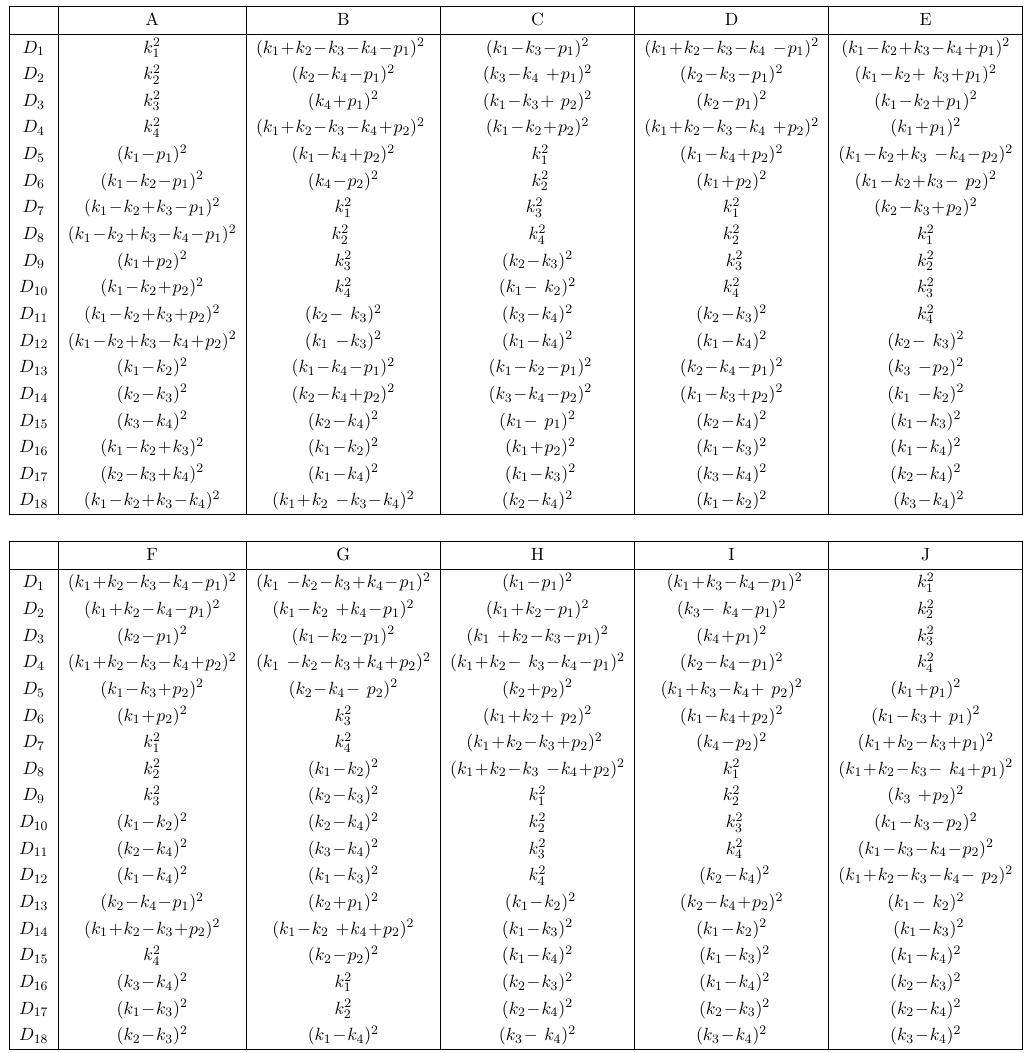
Table 1 . A complete set of integral families for massless three-point functions with one off-shell leg at four